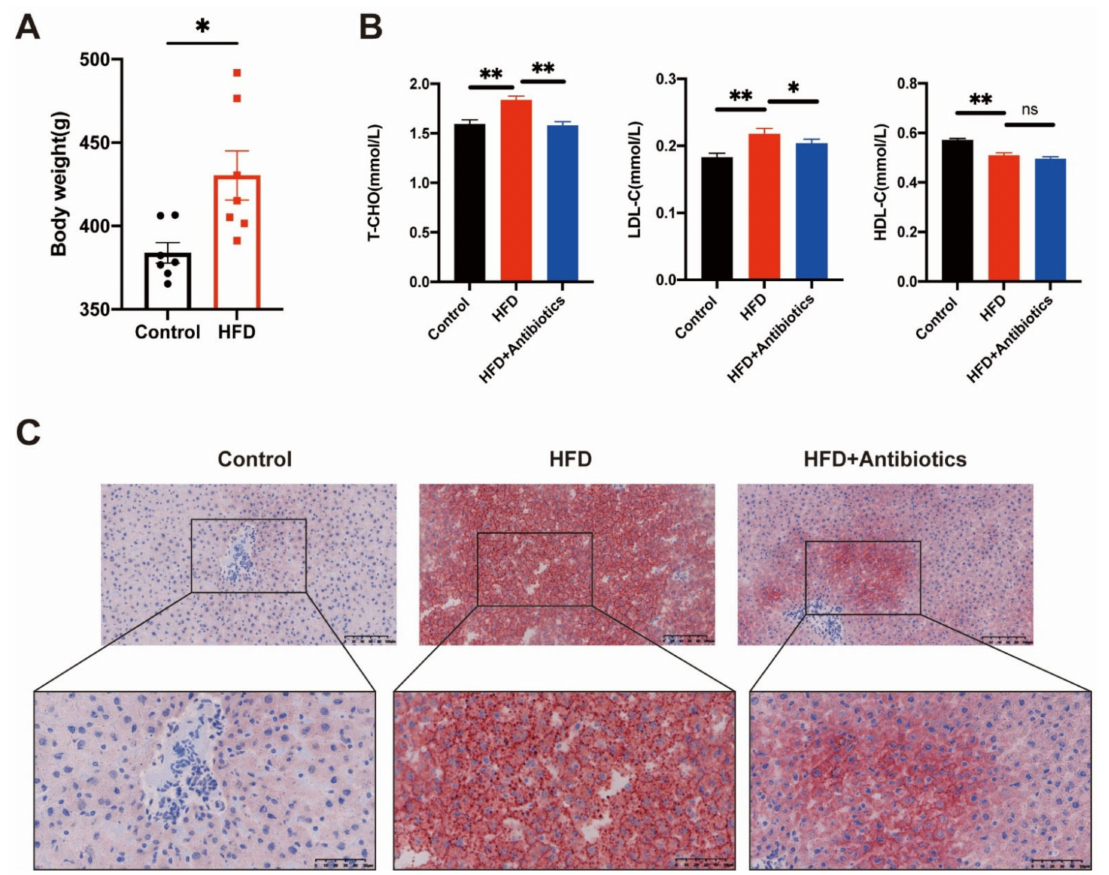
Figure 1. Treatment of a high-fat diet could induce lipid accumulation and dyslipidemia in rats. ( A ) The administration of high-fat food for eight weeks effectively increased body weight gain in Wistar rats. ( B ) Levels of HDL-C, T-CHO, and LDL-C in rats at eight weeks of administration. ( C ) Hepatic oil red O stain of liver tissue sections collected from rats. Scale bars respectively represent 100 µ m and 50 µ m. Data represent means ± SEM. * p < 0.05; ** p < 0.01, ns: no significant. (Control, n = 7; HFD, n = 7; HFD+Antibiotics, n =